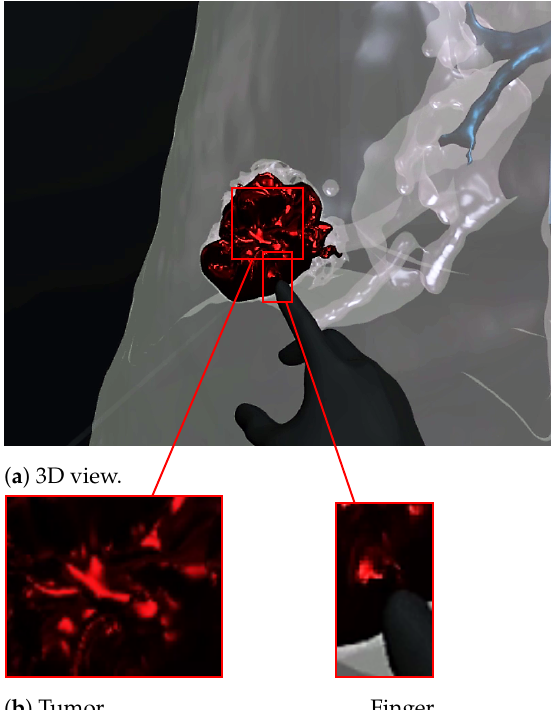
Figure 8. Virtual reality viewer of the finger touching and interacting with the tumor. The user feels a slight increase in his index finger’s temperature, which corresponds to the tumor’s temperature (40 °C according to